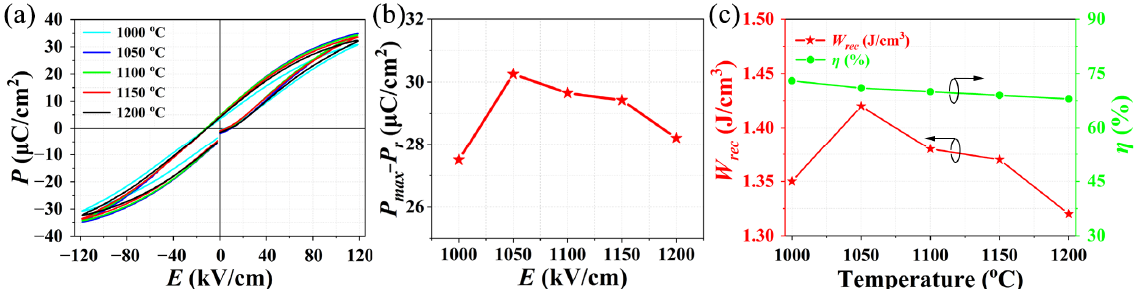
Figure 6. ( a ) Room temperature P-E loops of NBT-BT-NN ferroelectric ceramics at different sintering temperatures. ( b ) P max −P r values of each ceramic. ( c ) The W rec and η of NBT-BT-NN ferroelectric ce- temperatures. ( b ) P max − P r values of each ceramic. ( c ) The W rec and η of NBT-BT-NN ferroelectric ramics at different sintering temperatures. ceramics at different sintering